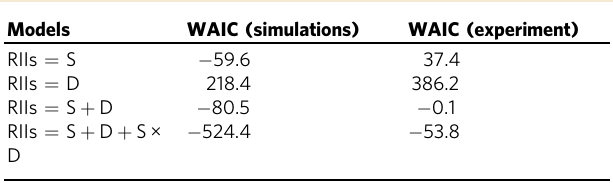
WAIC is used to compare these Bayesian models in model simulations and the experiment, respectively, and the model with smaller WAIC value is considered to be a better model. RII relative interaction index, S stress in model simulations or salinity level in the experiment, D density, WAIC Watanabe – Akaike information